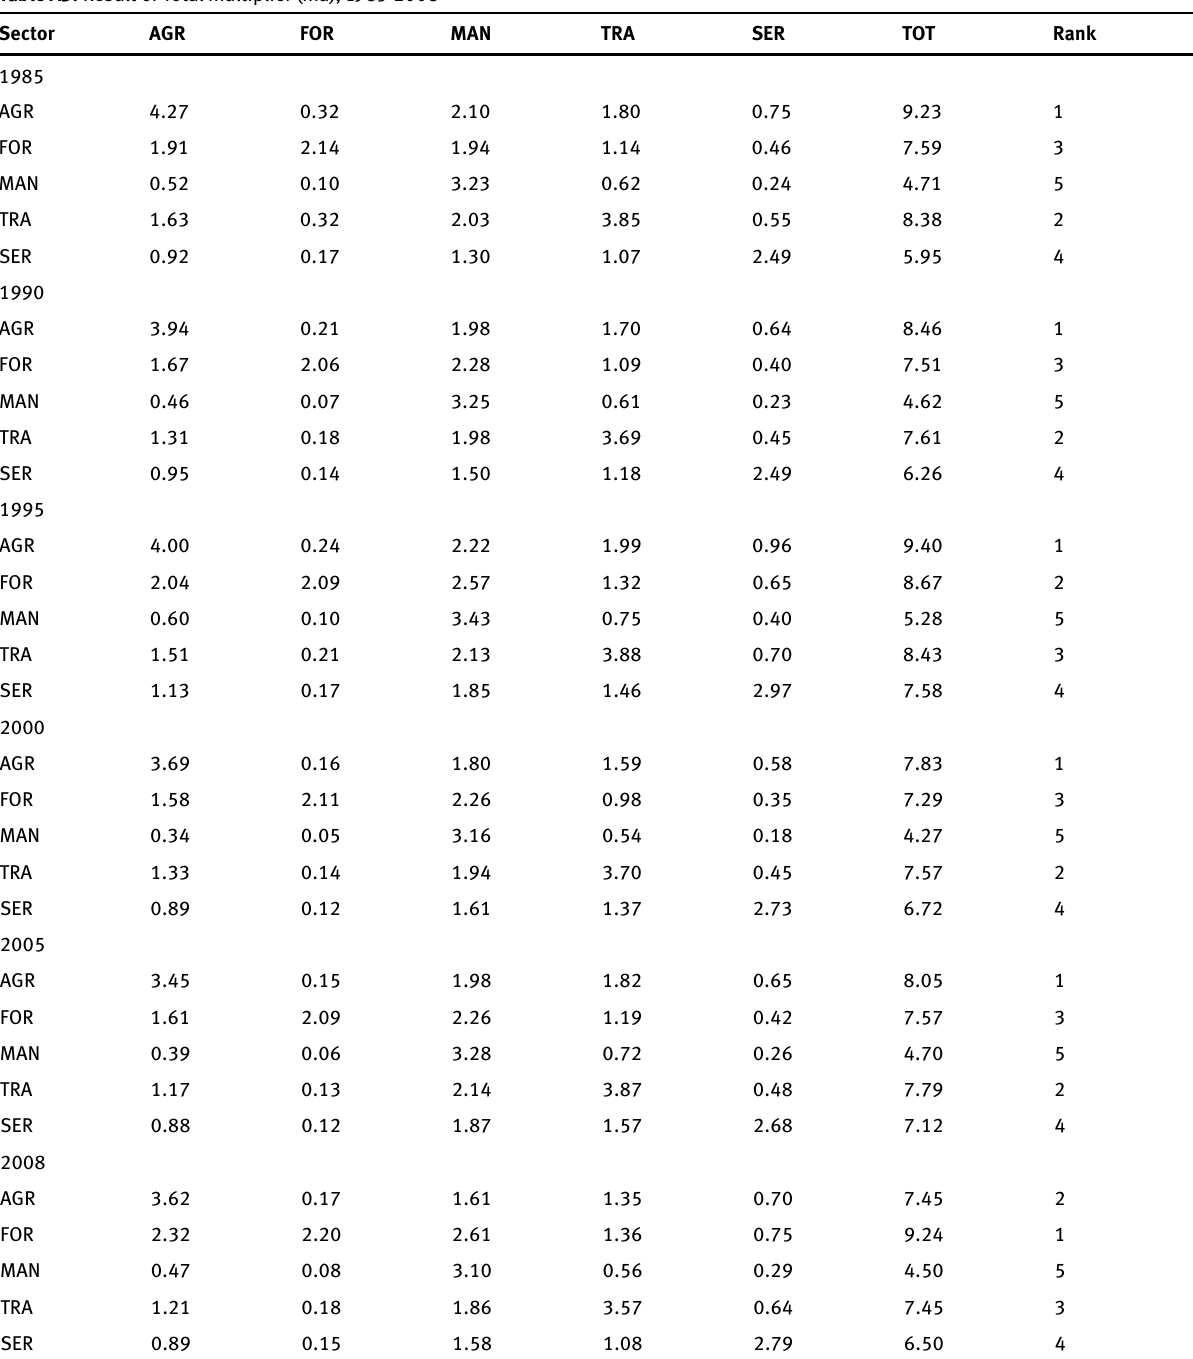
Table A3: Result of Total Multiplier (Ma), 1985-2008 Sector AGR FOR MAN TRA SER TOT Rank 1985 AGR FOR